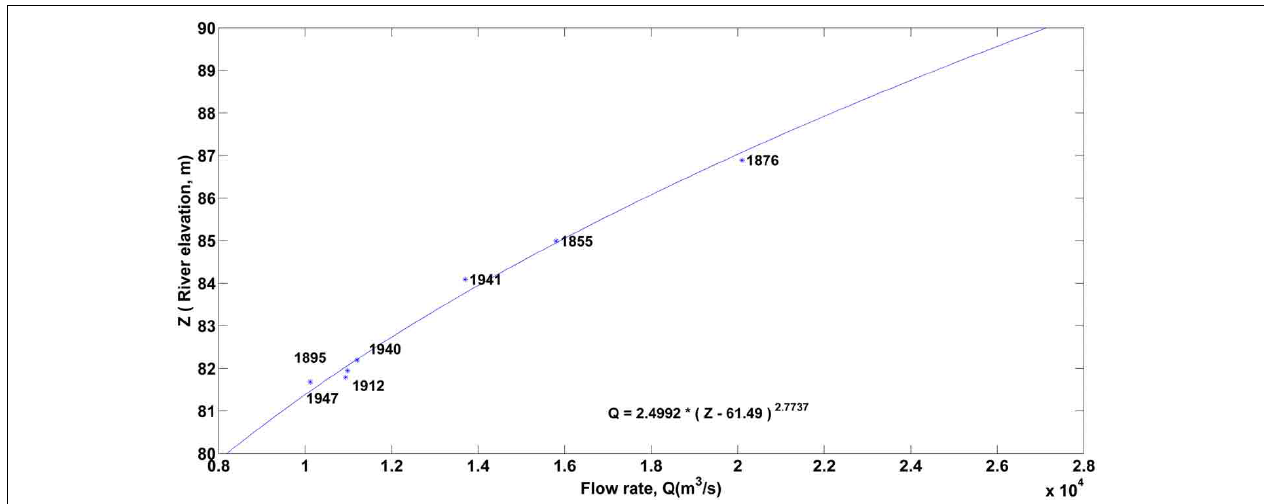
FIGURE 4 | Relation between river elevation (y-axis) and flow rate (x-axis) according to Loureiro (2009).